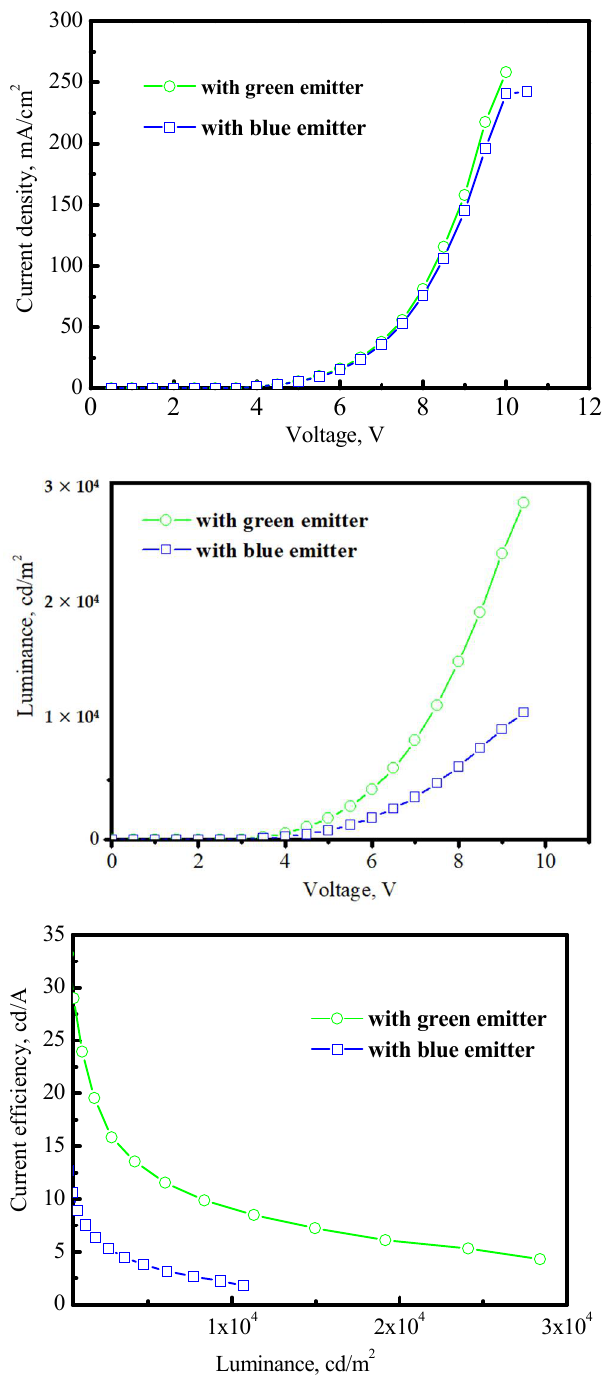
Figure 5. Characteristics of OLEDs with host H1 with Ir(ppy) 3 or FIrpic dopants in emitting layers. To demonstrate the characteristics of the compound H1 as a host of blue OLEDs, phosphorescent devices were formed by taking blue FIrpic dopant as the guest. The structure of the produced OLED is also described in the Experimental part. The material H1 was also tested in concentration-dependent emitting layers. As it could be seen from Figure 5, the blue OLED with 20 wt.% of FIrpic as the dopant demonstrated the best overall characteristics with a low turn-on voltage of ca. 3 V, 18.3 cd/A of maximum current efficiency, maximum power efficiency of 12.7 cd/A, and 10,700 cd/m 2 exceeding maximum brightness. The efficiency roll-off at a high current, which is typical for phosphorescent devices, was also seen here; however, at 1000 cd/m 2, brightness, a rather high efficiency of about 13.7 cd/A (8.3 lm/W) was still registered in the blue device. The other host material, H2, was also applied in blue devices by using blue FIrpic dopant as the emitter. In order to optimize the concentration of the dopant in the emitting layer, H2 was applied as the host in concentration-dependent experiments with the FIrpic amount ranging from 15 to 22.5 wt.%. Table 1 summarizes the OLED characteristics and efficiencies of the investigated PhOLEDs. It was observed that the OLED with 15 wt.% of the FIrpic doping ratio demonstrated the best characteristics with 23.9 cd/A of current efficiency, 24.9 lm/W of power efficiency, and high external quantum efficiency of 10.3% at a brightness of 100 cd/m 2 . At a higher brightness of 1000 cd/m 2 , which is desired for illumination technologies, this device also had the highest efficiency of 8.0% (18.4 cd/A, 15.8 lm/W) among all the blue devices using host H2 . The maximum luminance of the OLED exceeded 9170 cd/m 2 . The host material H2 was also applied as a component of green PhOLEDs in concentration-dependent tests with the Ir(ppy) 3 dopant amount in the range from 7.5 to 15 wt%. Table 1 summarizes the properties of the PhOLEDs. It can be mentioned that material H2 -based green PhOLEDs had reasonable better performance than that of derivative H1 using OLEDs. The devices with host H2, using dopant concentration ranging from 10 to 15 wt%., demonstrated rather low turn-on voltages of 2.6 – 3.3 V, power efficiencies of 26.2 – 34.1 lm/W, current efficiencies of 10.3 – 20.6 cd/A, and high external quantum efficiencies of 3.3 – 5.7% at a brightness of 100 cd/m 2 . As it could be observed, the 10 wt.% of Ir(ppy) 3 containing OLED had the best characteristics with a current efficiency of 33.9 cd/A, power efficiency of 34.1 lm/W, and high external quantum efficiency of 9.4% at 1000 cd/m 2 brightness, which is applied for illumination applications. The maximal brightness of the OLED reached almost 39,000 cd/m 2 .